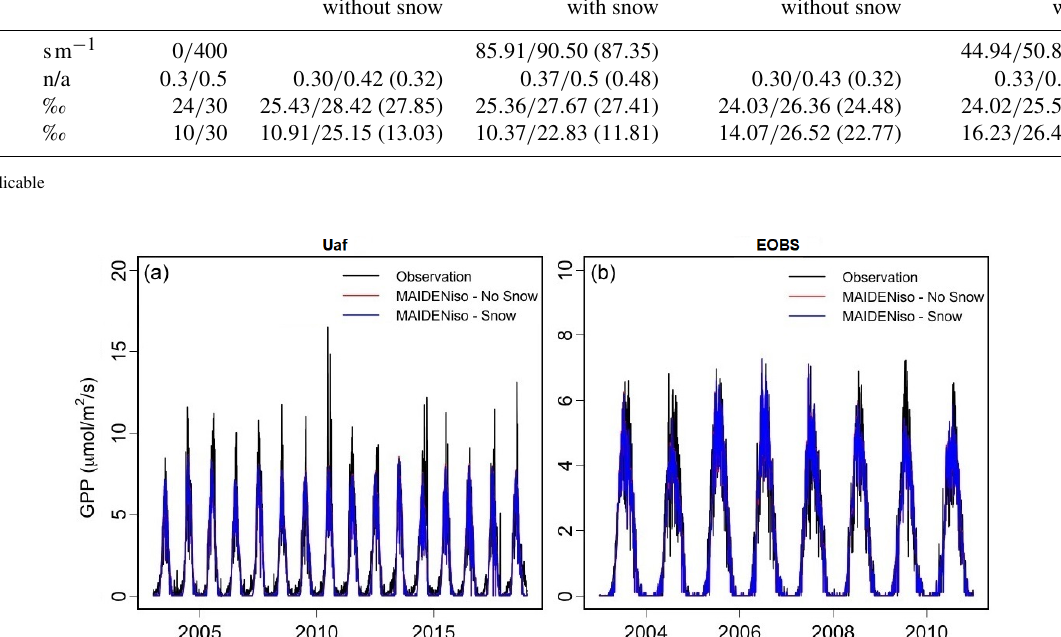
Figure 5. GPP at the Uaf site (a) and the EOBS site (b) . We show observations from flux towers (black) and MAIDENiso simulations without (red) and with (blue) snow processes. Independent optimizations are run for the two versions of MAIDENiso. A t test determined that the GPP simulated by the model with and without snow are statistically not different; for this reason, the red line is overlapped by the blue